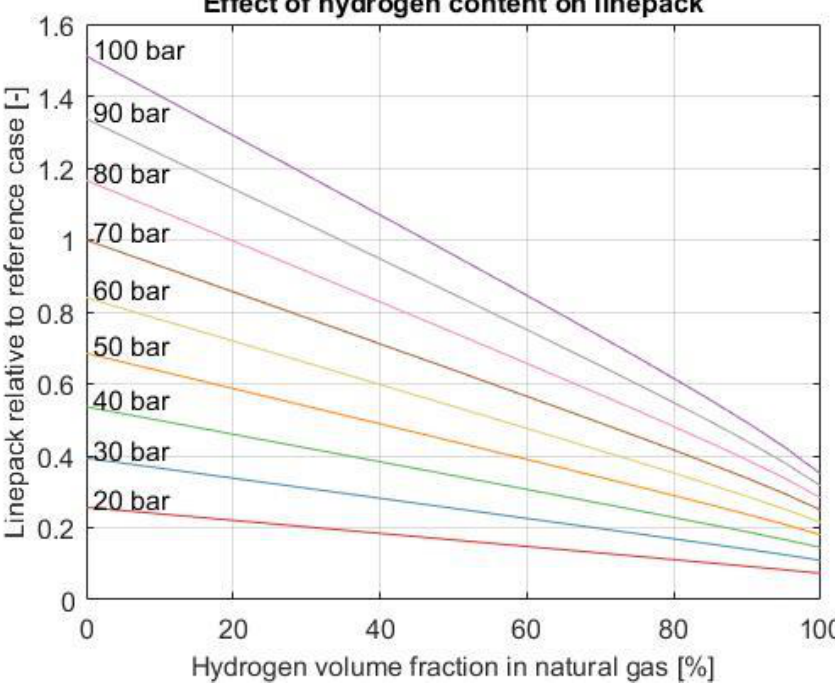
Figure 7. Energy buffer in H2-Pipeline as function of H2 volume fraction at different pressures.